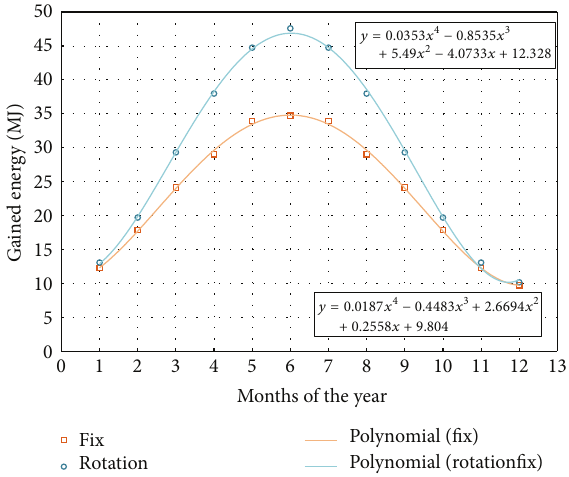
Figure 21: Theoretically determined average monthly values of the gained energy for each month throughout the year for both the rotary system and the static system.